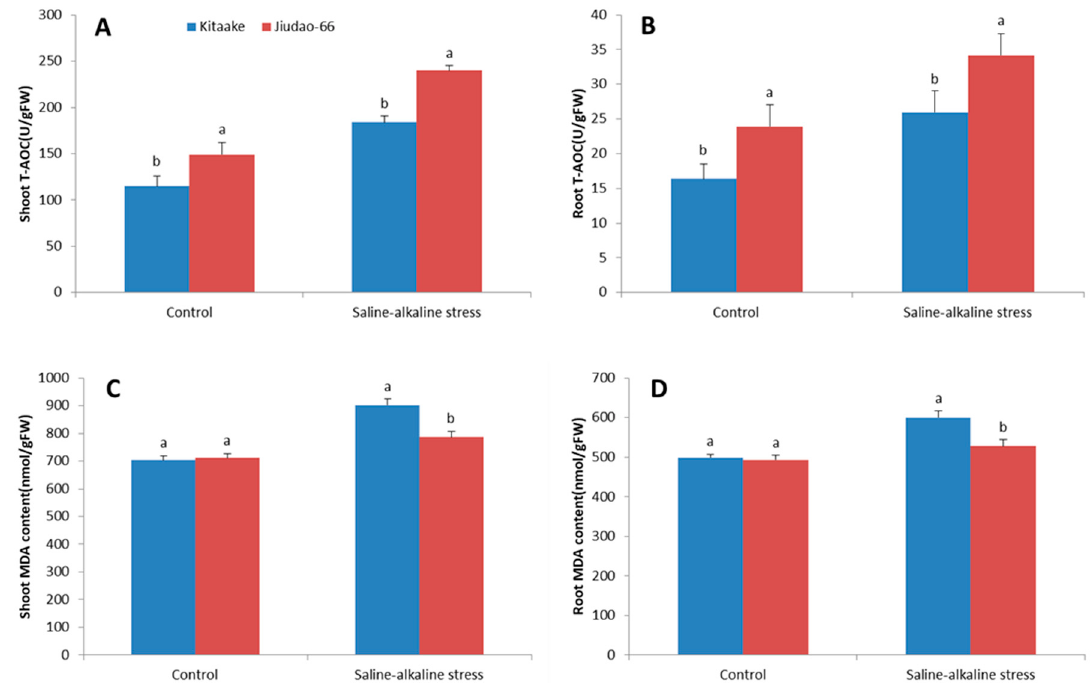
Figure 5. ( A , B ) Total antioxidant capacity (T-AOC) and ( C , D ) malondialdehyde (MDA) content of shoots and roots of Kitaake and Jiudao-66 seedlings grown in normal and saline–alkaline stress conditions. Treatments and statistical analyses were as described in Figure 2. Different letters (a, b) indicate significant differences at p < 0.05.